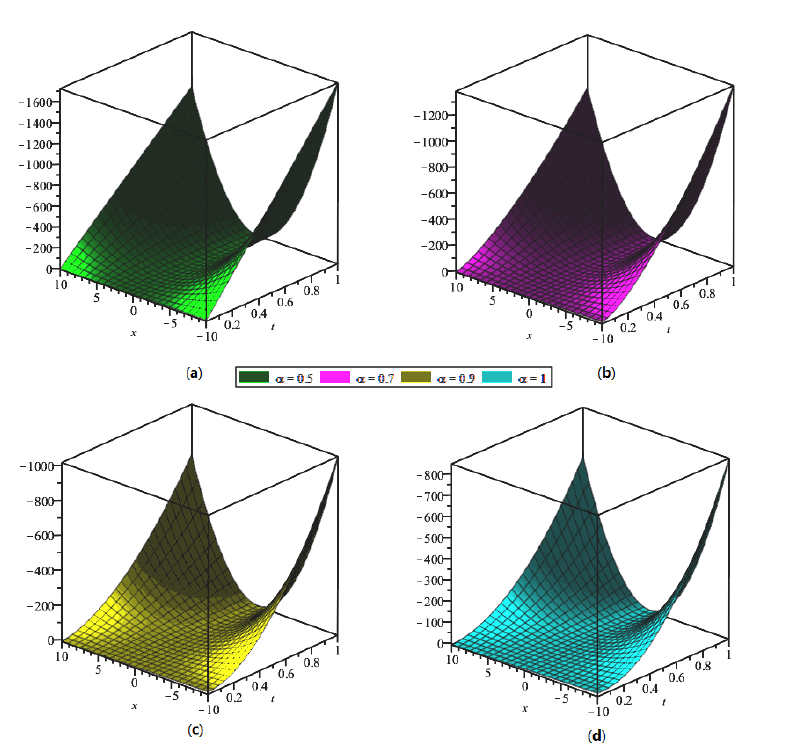
Figure 5. The analytical solution for u ( ϕ , τ ) at A = 17 Example 2.